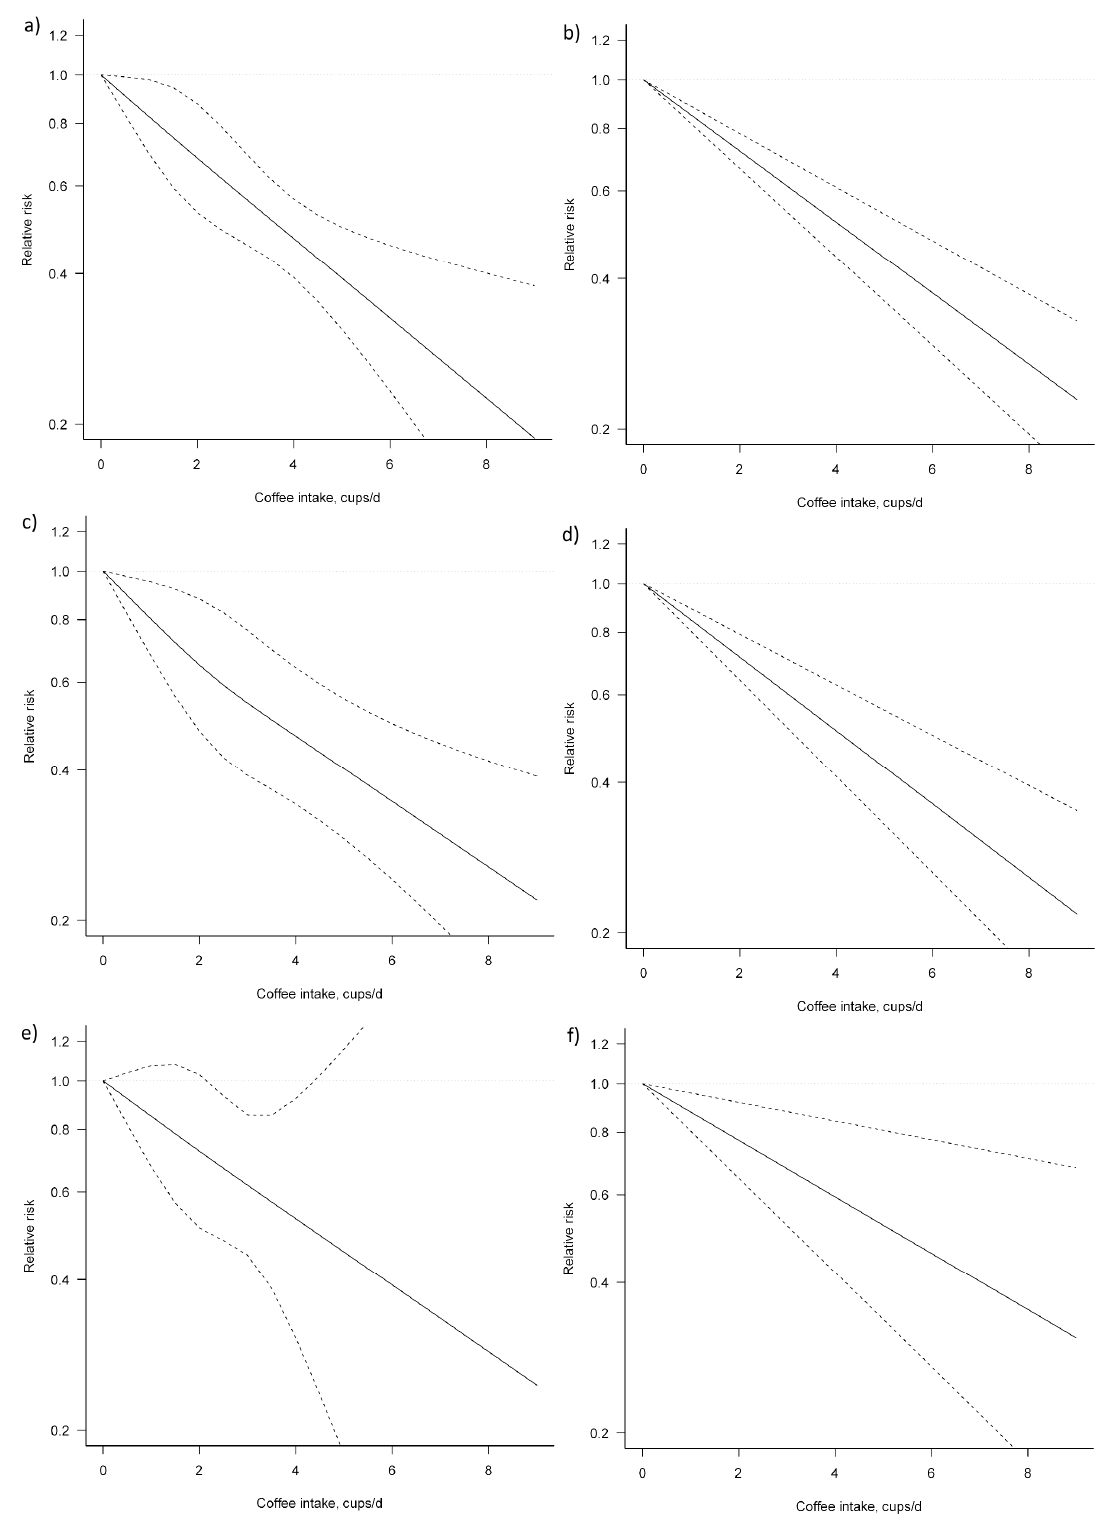
Figure 5. Dose–response association between coffee consumption and liver cancer risk: ( a ) non-linear, total analysis; ( b ) linear, total analysis; ( c ) non-linear, male; ( d ) linear, male; ( e ) non-linear, female; and ( f ) linear, female. Solid lines represent relative risk, while dashed lines represent 95% confidence intervals.